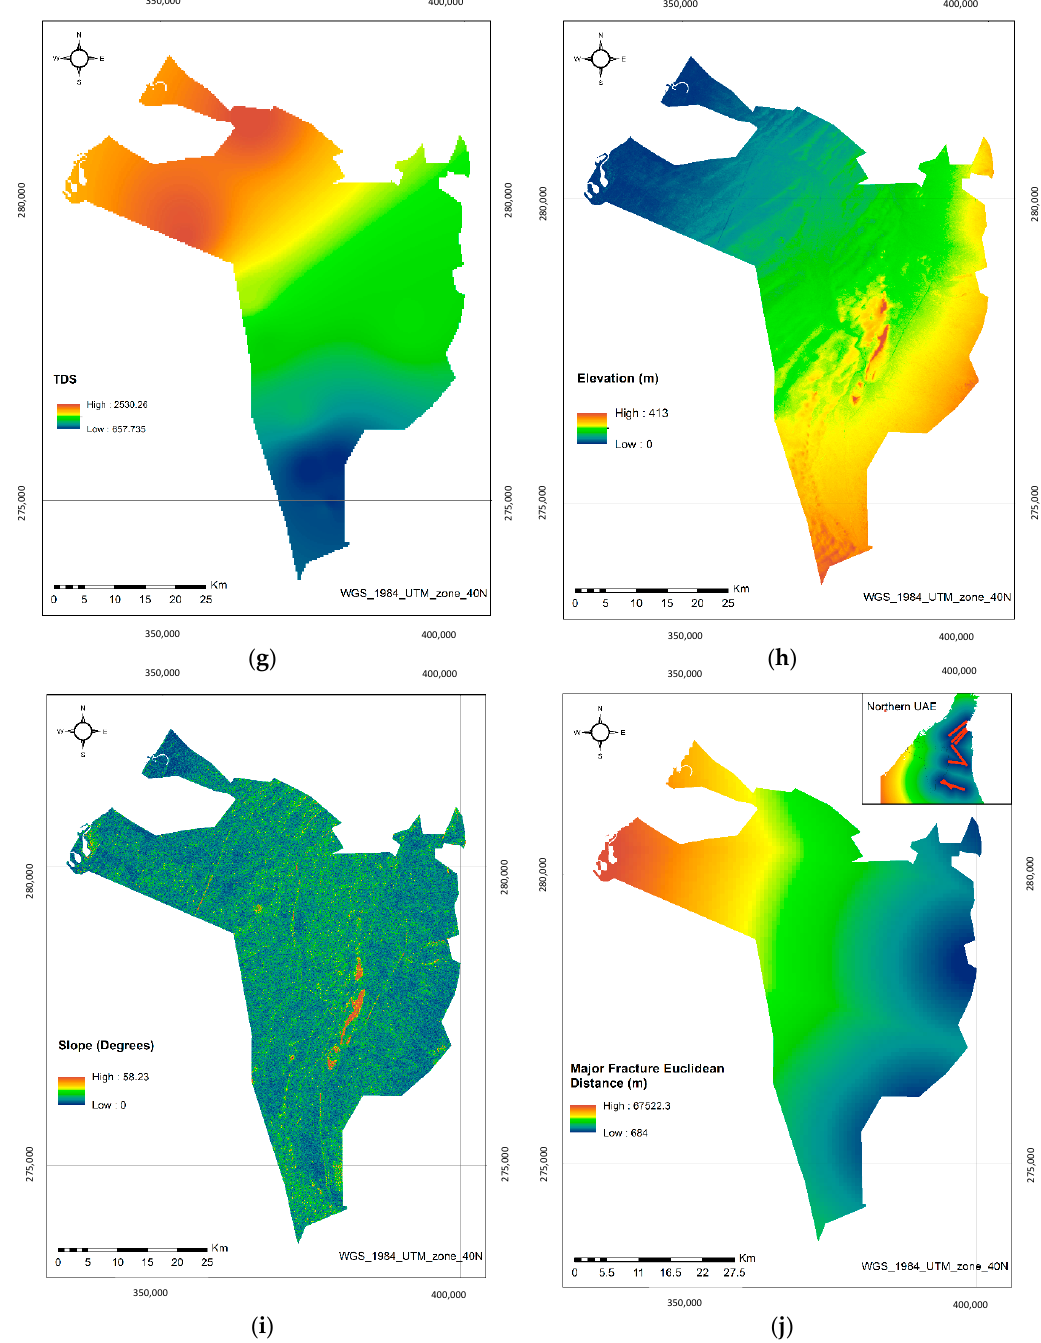
Figure 3. Major thematic layers. ( a ) Precipitation; ( b ) Streams & Basins; ( c ) Drainage Stream Density; ( d ) Geomorphology; ( e ) Geology; ( f ) Curve Number; ( g ) Total Dissolved Solid (TDS); ( h ) Elevation; ( i ) Slope; ( j ) Major Fracture Euclidian